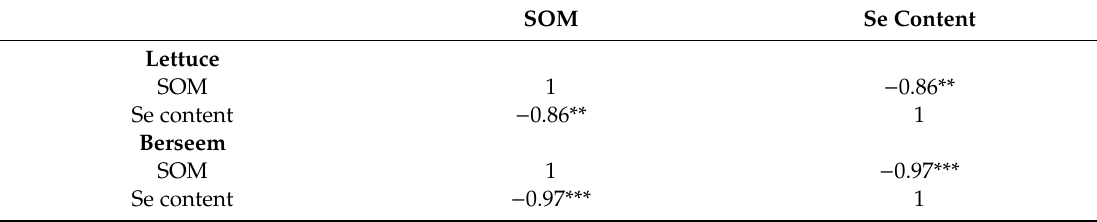
Table 4. Correlation between leaf Se content and soil organic matter (SOM) content for lettuce and berseem plants.